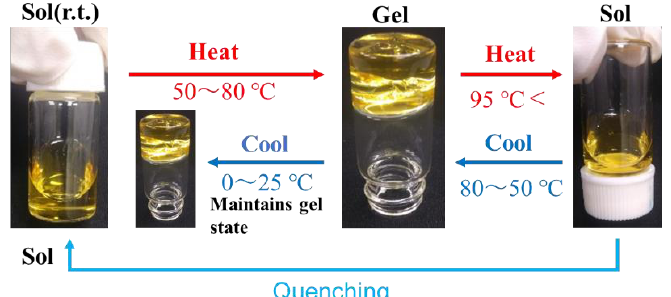
Figure 1. Sol-gel transition behavior of PU-1 with BMI in DMAc solution.